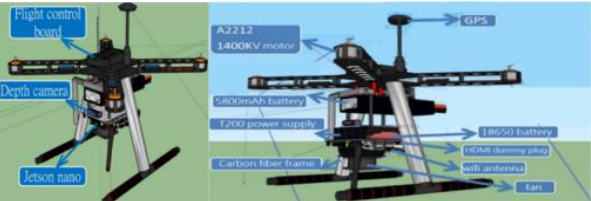
Figure 1. Architecture of the miniature quadcopter drone implemented in this research.